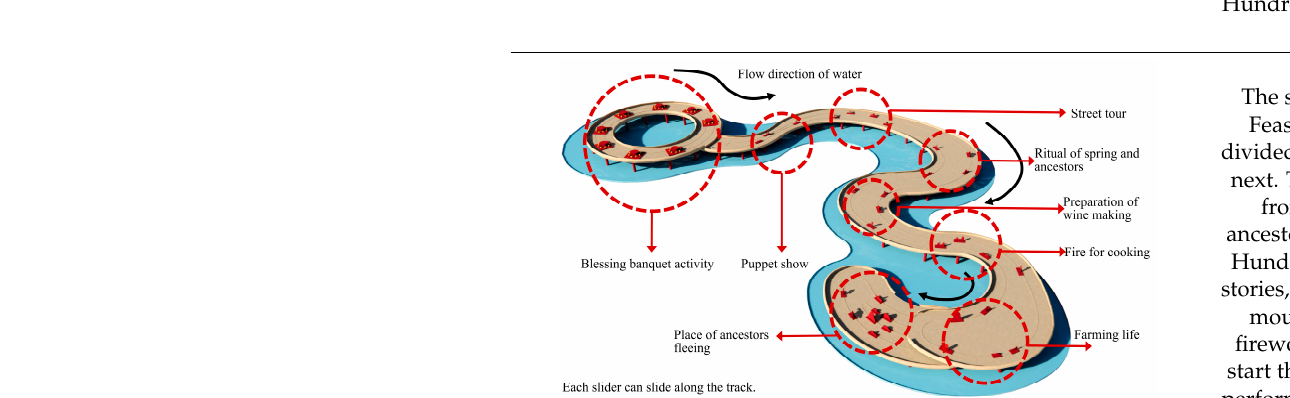
Landscape element carrier